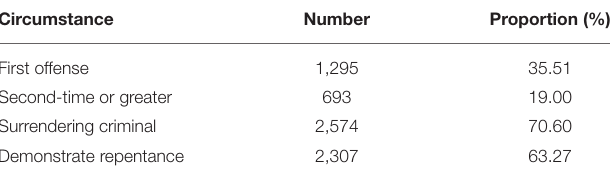
TABLE 4 | Punishments and circumstances.